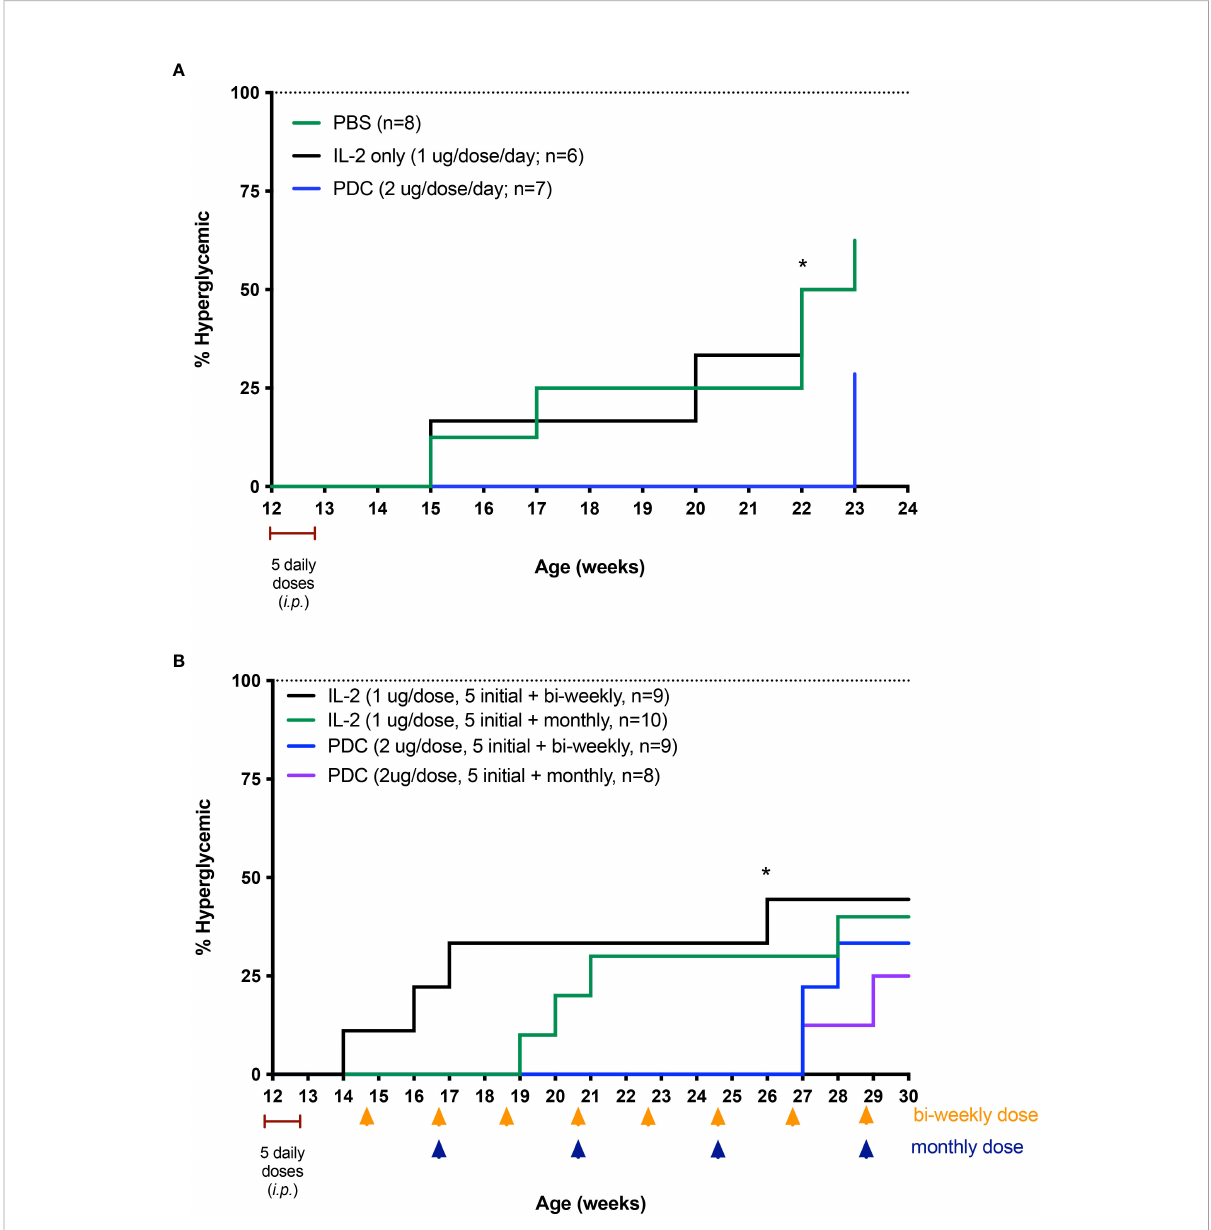
FIGURE 7 Therapeutic effect of the PDC, protein drug conjugate (ATA-003) in preventing disease in the NOD mouse model of T1D. (A) NOD mice were treated i.p . with low-dose IL-2 (1 m g; 25,000 IU/day), PDC (2 m g/day), or an equal volume of PBS, phosphate buffered saline (0.1 ml) for 5 consecutive days starting at 12 weeks of age. Disease incidence was signi fi cantly different between PDC vs. PBS-treated groups (P < 0.04), and between PDC vs. IL-2 treated groups (P < 0.04; Log rank Mantel-Cox test) at 22 weeks of age. Separate cohorts of NOD mice were treated similarly but with an additional dose of PDC or IL-2 administered every 2 weeks (yellow arrows) or every month (blue arrows) after the initial 5 daily doses (B) . Blood sugar was measured weekly until mice became hyperglycemic. Disease incidence was signi fi cantly different between biweekly treated PDC vs. biweekly treated IL-2 groups at 26 weeks of age (* P < 0.03; Log rank Mantel-Cox